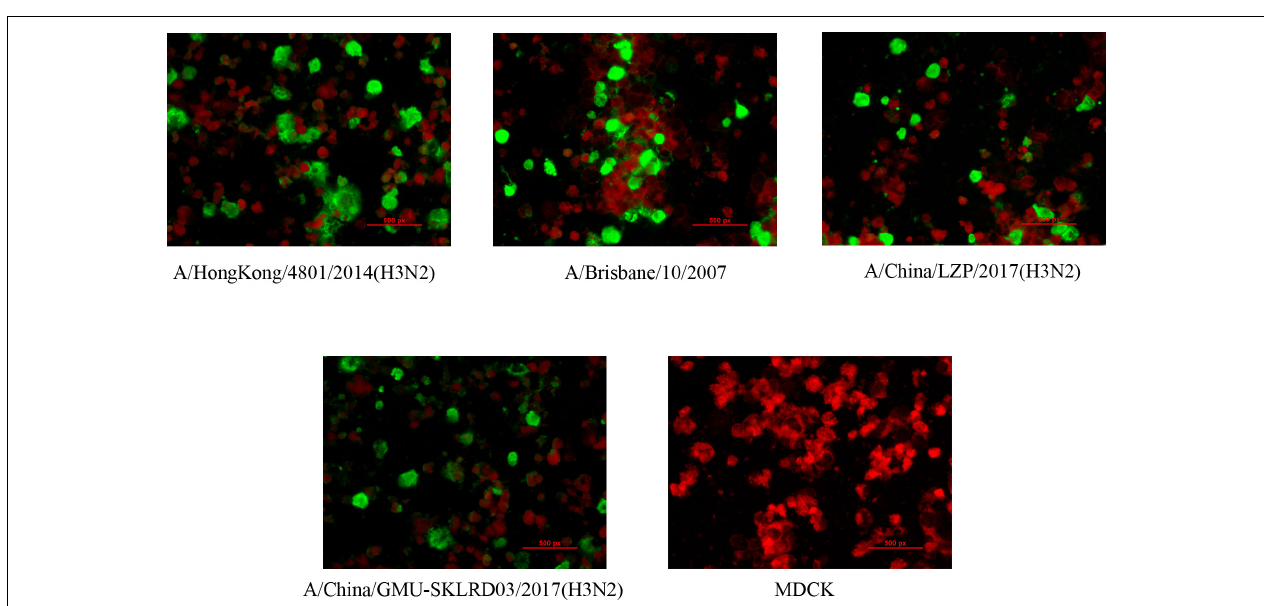
FIGURE 1 | Immunofluorescence assay for detecting H3N2 clinical specimens. The nucleoproteins (NPs) of H3N2 viruses were determined by the D3 Ultra DFA Respiratory Virus Screen and ID Kit. H3N2 strains (LZP, GMU03) and B10- or HK4801-infected cells were fixed in 4% paraformaldehyde at 37 ◦ C for 30 min. FITC-labeled mouse anti-NP antibody was used to detect nucleoprotein. The cells were observed using a fluorescence microscope.